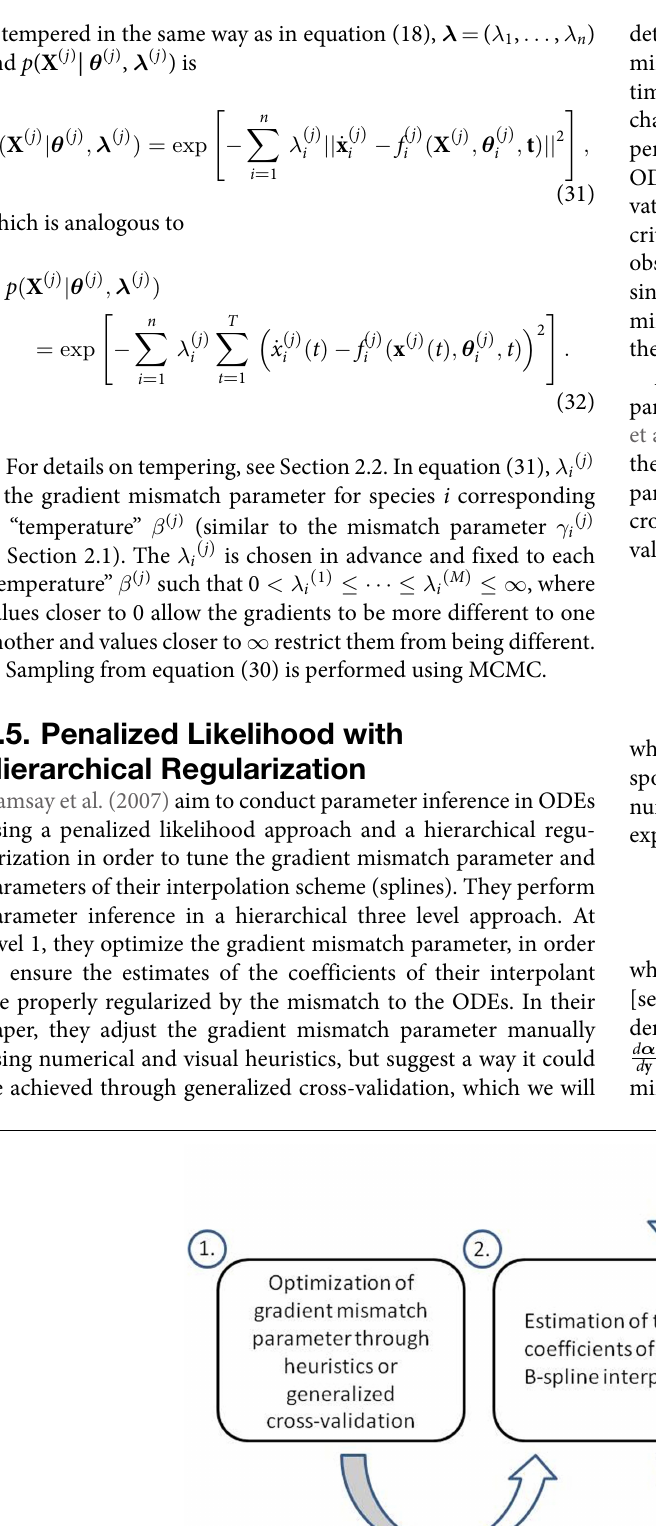
Fr ontiers in Bioengineering and Biotechnology |